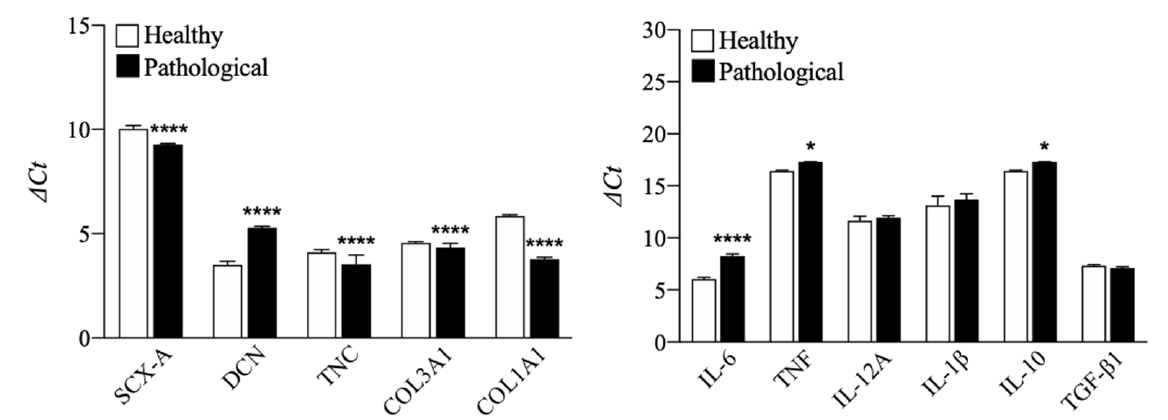
Figure 2. qRT-PCR characterization of tendon stem/progenitor cells (TSPCs) extracted from healthy and pathological tendon samples. The histograms show gene expression profile for tenogenic (SCX-A, DCN, TNC, COL3A1, COL1A1) and cytokines (pro-inflammatory: IL-6, TNF, IL-12A, IL-1β; anti-inflammatory: IL-10, TGF-β1) markers before treatment (day 0). Data were expressed as ΔCt, normalizing each gene of interest to GAPDH (housekeeping gene). Results are shown as mean±SD. * p < 0.05 and **** p < 0.0001 (N = 4).